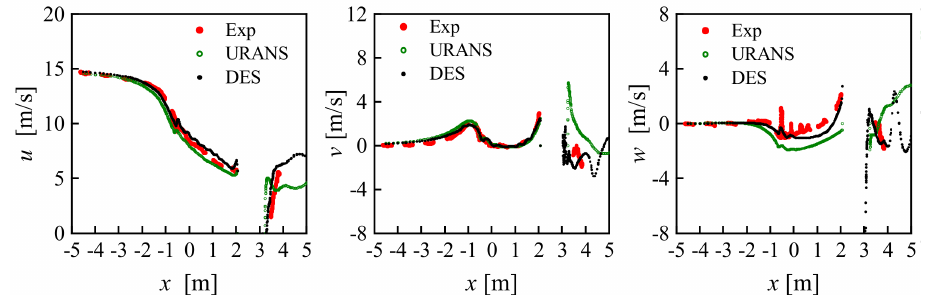
Figure 21. Axial profile of velocity components at y = 1.5 m under wind speed of 15 m/s, TSR = 6.7.